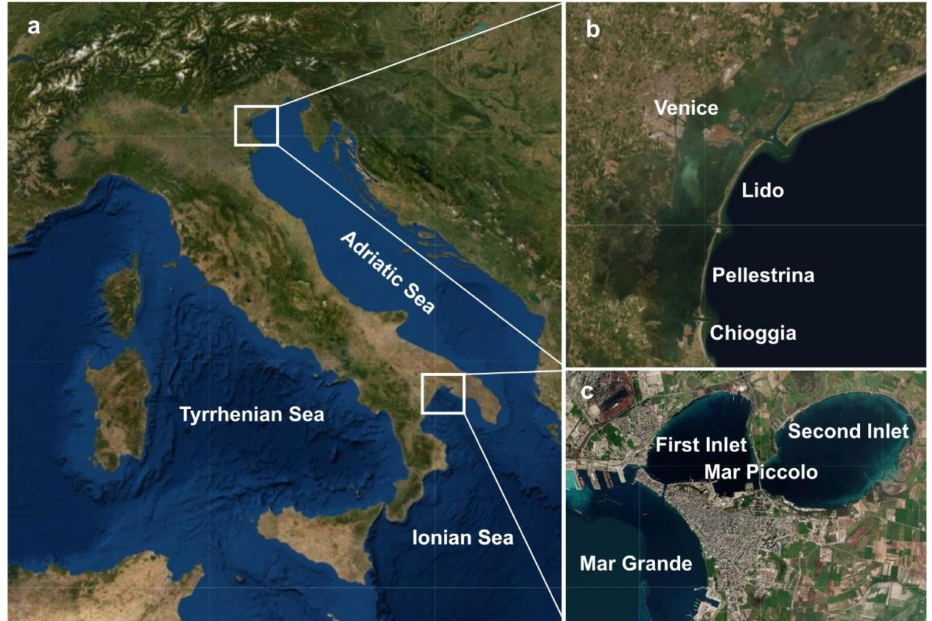
Figure 1. Sampling sites. ( a ) Map of the Italian peninsula showing the position of the studied areas (squares), ( b ) map of the Venice Lagoon, ( c ) map of the Mar Piccolo of Taranto. The maps were created using the National Geographic MapMaker (https: //